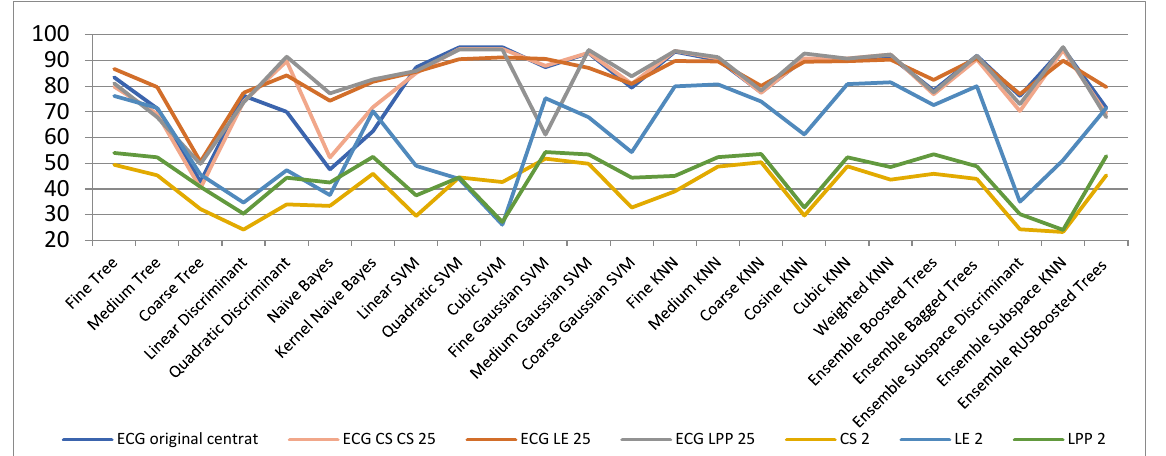
Figure 3. Classification results with CS, LE, LPP methods for 2, 3 and 25 dimensions, respectively.